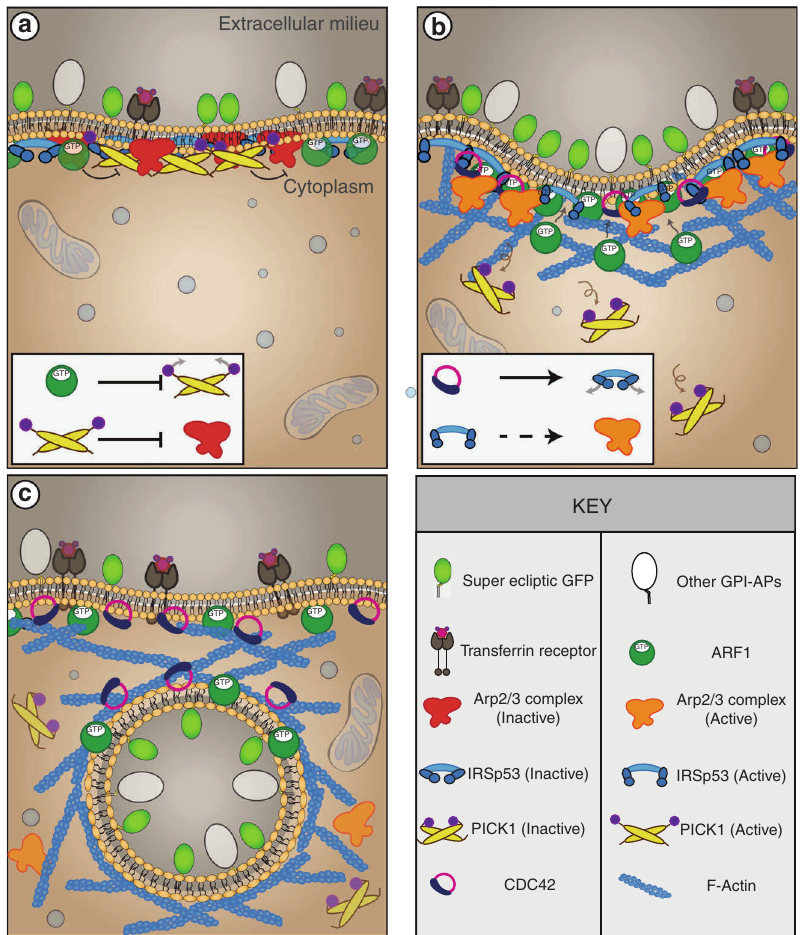
Fig. 8 Schematic depicting the proposed biphasic mechanism for CG endocytic vesicle formation. a Phase Ι : Characterised by the recruitment of ARF1/ GBF1, PICK1, ARP2/3 and IRSp53 but not the buildup of F-actin and CDC42. Here, IRSp53 may be recruited by its I-BAR domain in the absence of GTP- CDC42, keeping its SH3 domain in an intra-molecular inhibited state. PICK1 keeps ARP2/3 in an inactive state. b Phase ΙΙ : Characterised by the recruitment of CDC42 and a sharp increase in ARF1 leading to the removal of PICK1. This allows for the activation of ARP2/3 and buildup of F-actin. CDC42 binds to the CRIB domain of IRSp53 thereby activating it. The SH3 domain of IRSp53 can now bind to ARP2/3 activators and create F-actin. c Phase III: Characterised by endocytic vesicle formation, the presence of CDC42, ARF1/GBF1 and